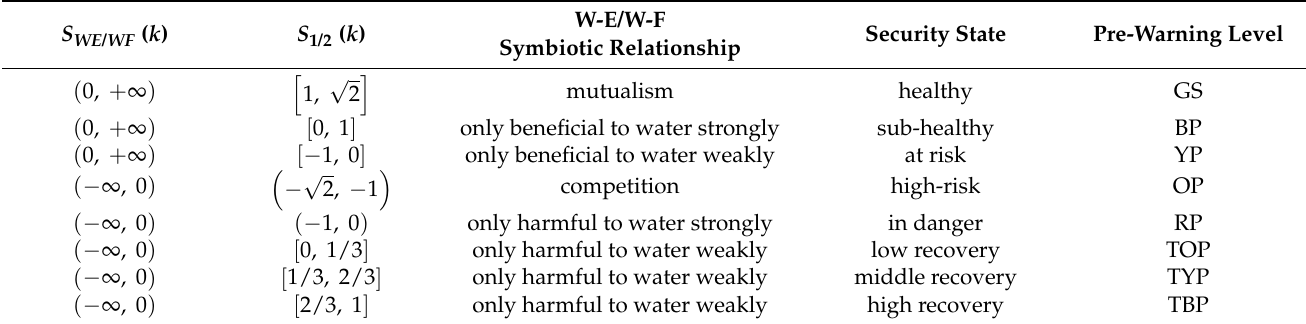
Table 2. The judgment criteria of water security state and pre-warning level from the perspective of water-energy symbiosis and water-food